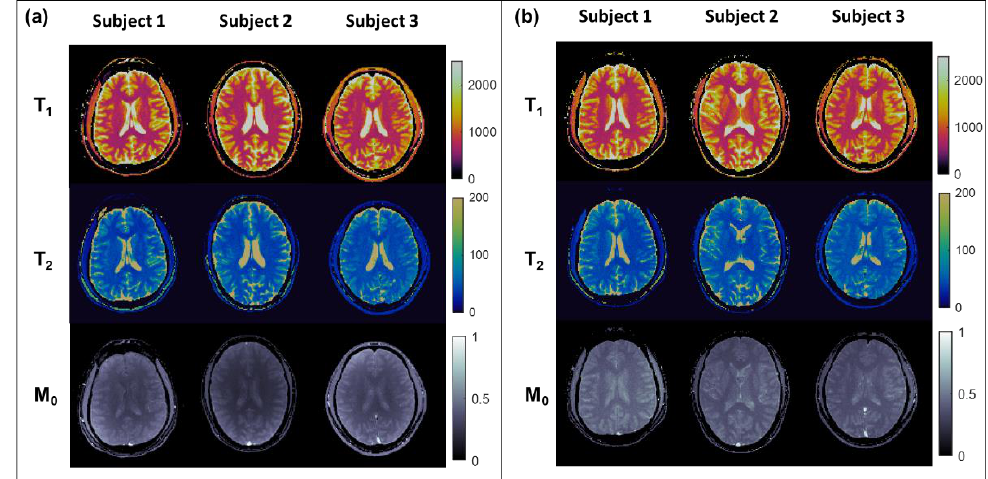
Figure 5. MRF maps of the brain from healthy subjects obtained from the new scanner ( a ) and the old scanner ( b ). T 1 and T 2 maps are of comparable overall quality, and values appear visually similar between corresponding tissue types. As also observed in phantom, M 0 maps differ in appearance between the two scanners, potentially due to differences in receive coil sensitivities. Table 1. Mean and standard deviation of T 1 and T 2 values of white matter obtained from the old and new scanners for each subject as well as intra-scanner and inter-scanner coefficients of variation. p -values correspond to comparisons of T 1 and T 2 values within subjects across scanners (shown in columns) and in test–retest (shown in row 1 (p)). Significant differences ( p < 0.05) are boldfaced.